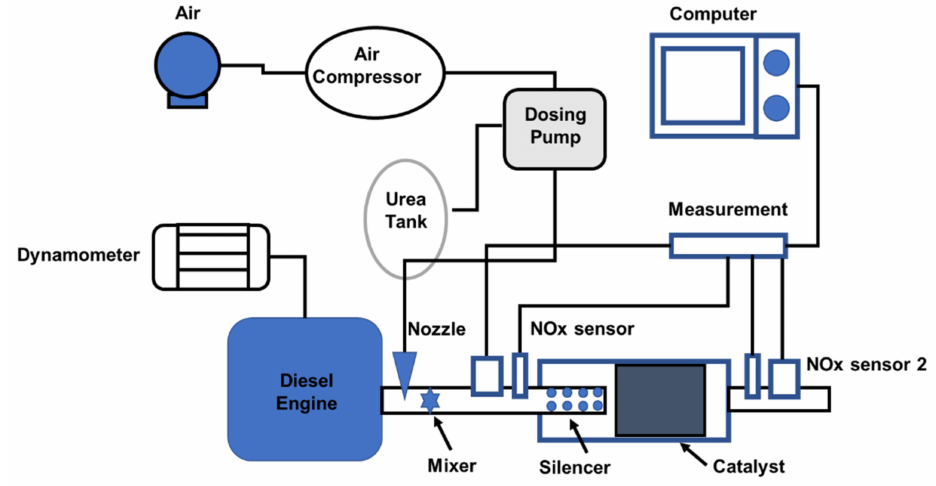
Figure 13. Experimental bench system of a urea–SCR system for a 3900 cc diesel engine